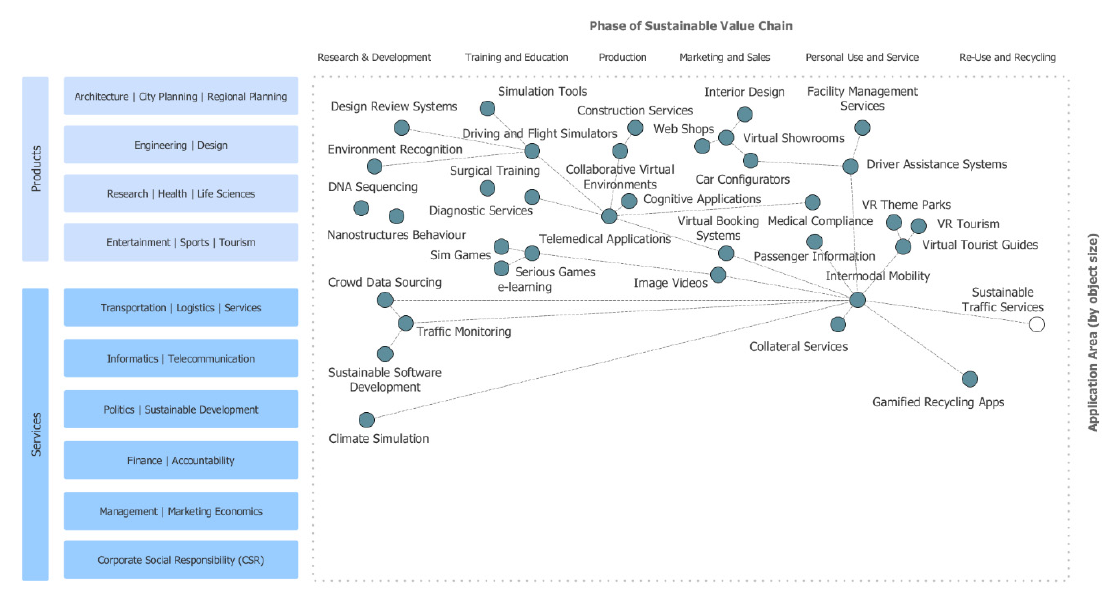
Figure 1. Applied interactive technologies (APITs) networking matrix [12].